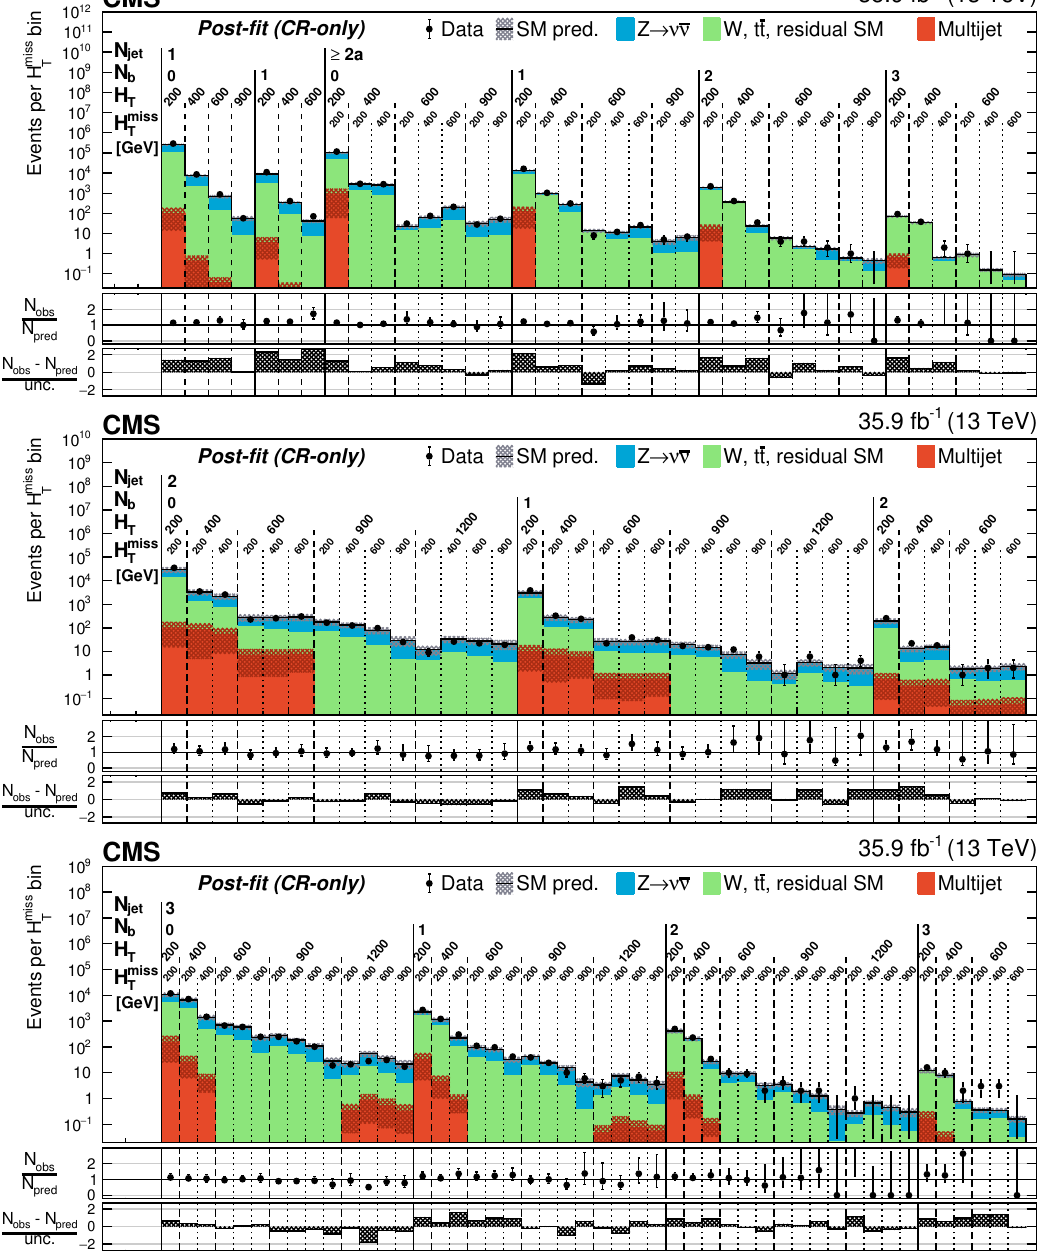
Figure 1 . Counts of signal events (solid markers) and SM expectations with associated uncer- tainties (statistical and systematic, black histograms and shaded bands) as determined from the CR-only (cid:12)t as a function of n b , H T , and H miss for the event categories n jet = 1 and (cid:21) 2 a (upper), T = 2 (middle), and = 3 (lower). The centre panel of each sub(cid:12)gure shows the ratios of observed counts and the SM expectations, while the lower panel shows the signi(cid:12)cance of deviations observed in data with respect to the SM expectations expressed in terms of the total uncertainty in the SM